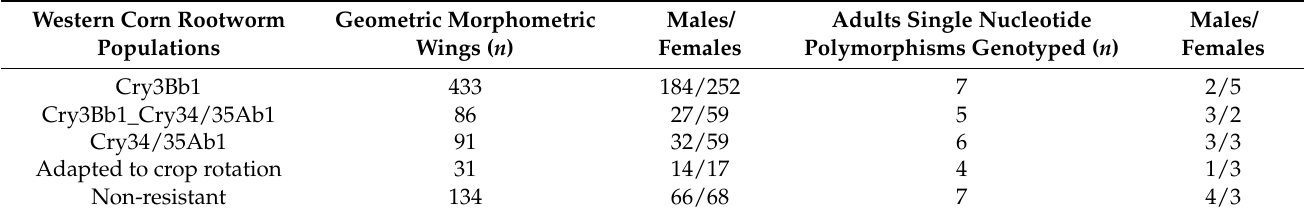
Table 1. Number of WCR individuals used for geometric morphometric and SNPs analyses. n = sample size. Western Corn Rootworm